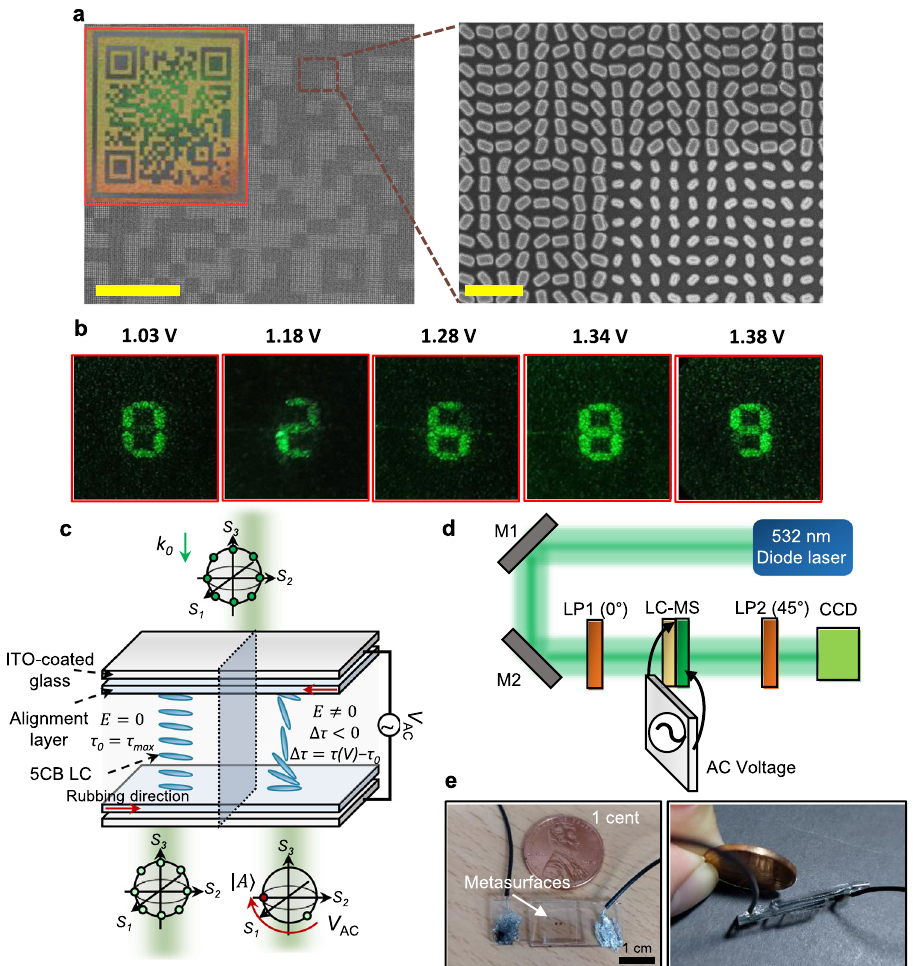
Fig. 4 Experimental demonstration of electrically tunable vectorial holographic device. a Optical (inset) and scanning electron microscope images of the fabricated device. Scale bars represent 50 µ m and 1 µ m, respectively. b Electrically tunable vectorial metaholograms according to different applied voltages on liquid crystals (LCs). c LC cell design schematic. Initial LC molecules are ordered parallel to the rubbing direction of polyimide alignment layer, where retardation τ of transmitted light has maximum value. By applying a voltage, the LC is ordered parallel to the electric bias direction, decreasing the retardation resulting in polarization change of transmitted light. All of the polarization states are tuned to be 135° linearly polarized light. d Optical